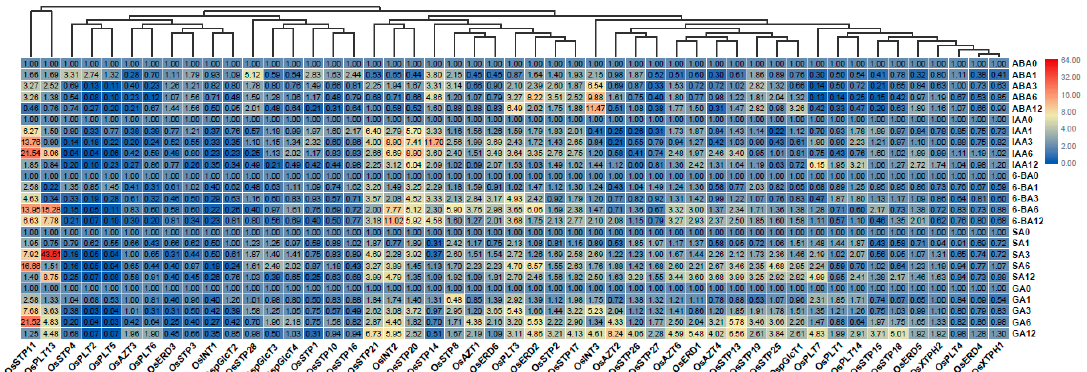
Figure 7. Expression changes of the MST genes under ABA, IAA, 6-BA, SA, and GA treatments by qRT-PCR. 0, 1, 3, 6, 12 represents 0 h, 1 h, 3 h, 6 h, and 12 h after hormone treatment. The fold values were calculated by the 2 − ∆∆ CT method. The heat map was made based on the fold changes. The color scale represents fold changes with red indicating high and green indicating low up-regulation.